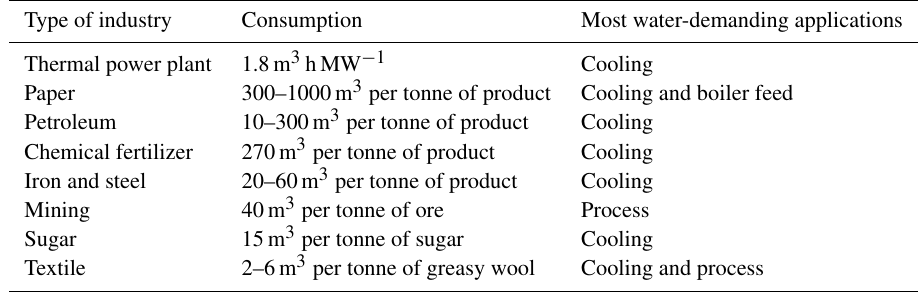
Table 2. Industrial water consumption for the most water-demanding industries. Adapted from Hunter (2001), Ranade and Bhandari (2014), Joint Research Council (2001), European Commission (2003), and Cooperman et al. (2012).